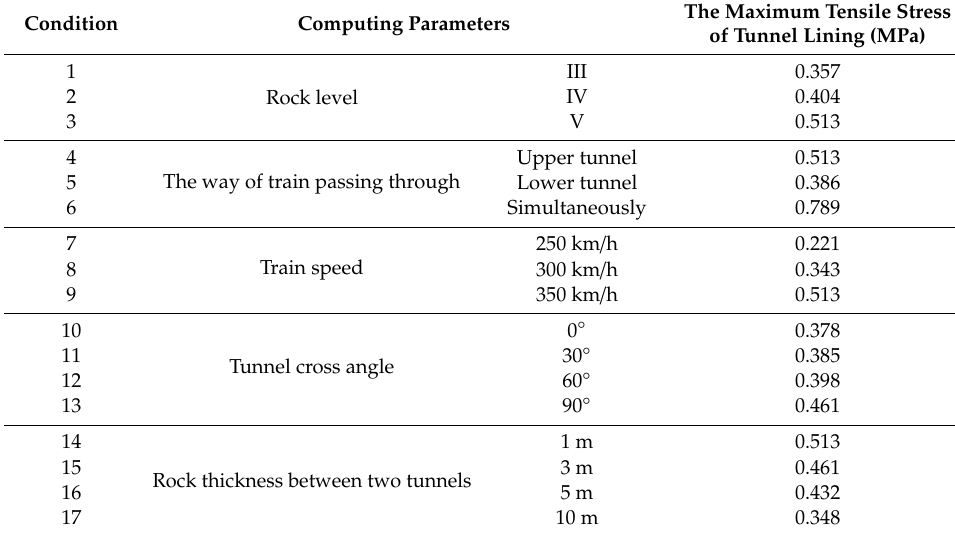
Table 7. Tensile stress increment of the tunnel lining under di ff erent working conditions.